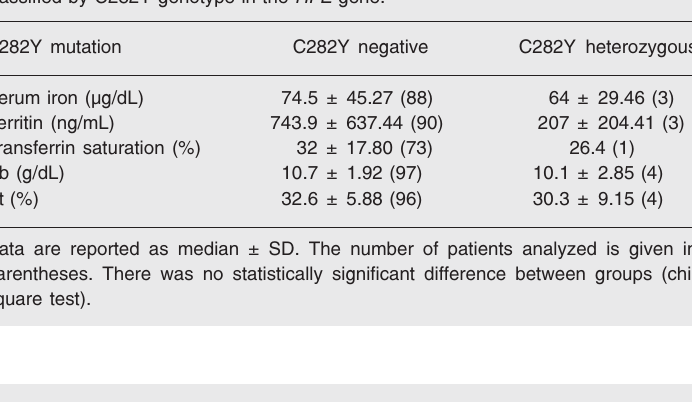
Table 2. Biochemical parameters of 118 patients with chronic renal insufficiency, classified by H63D genotype in the HFE